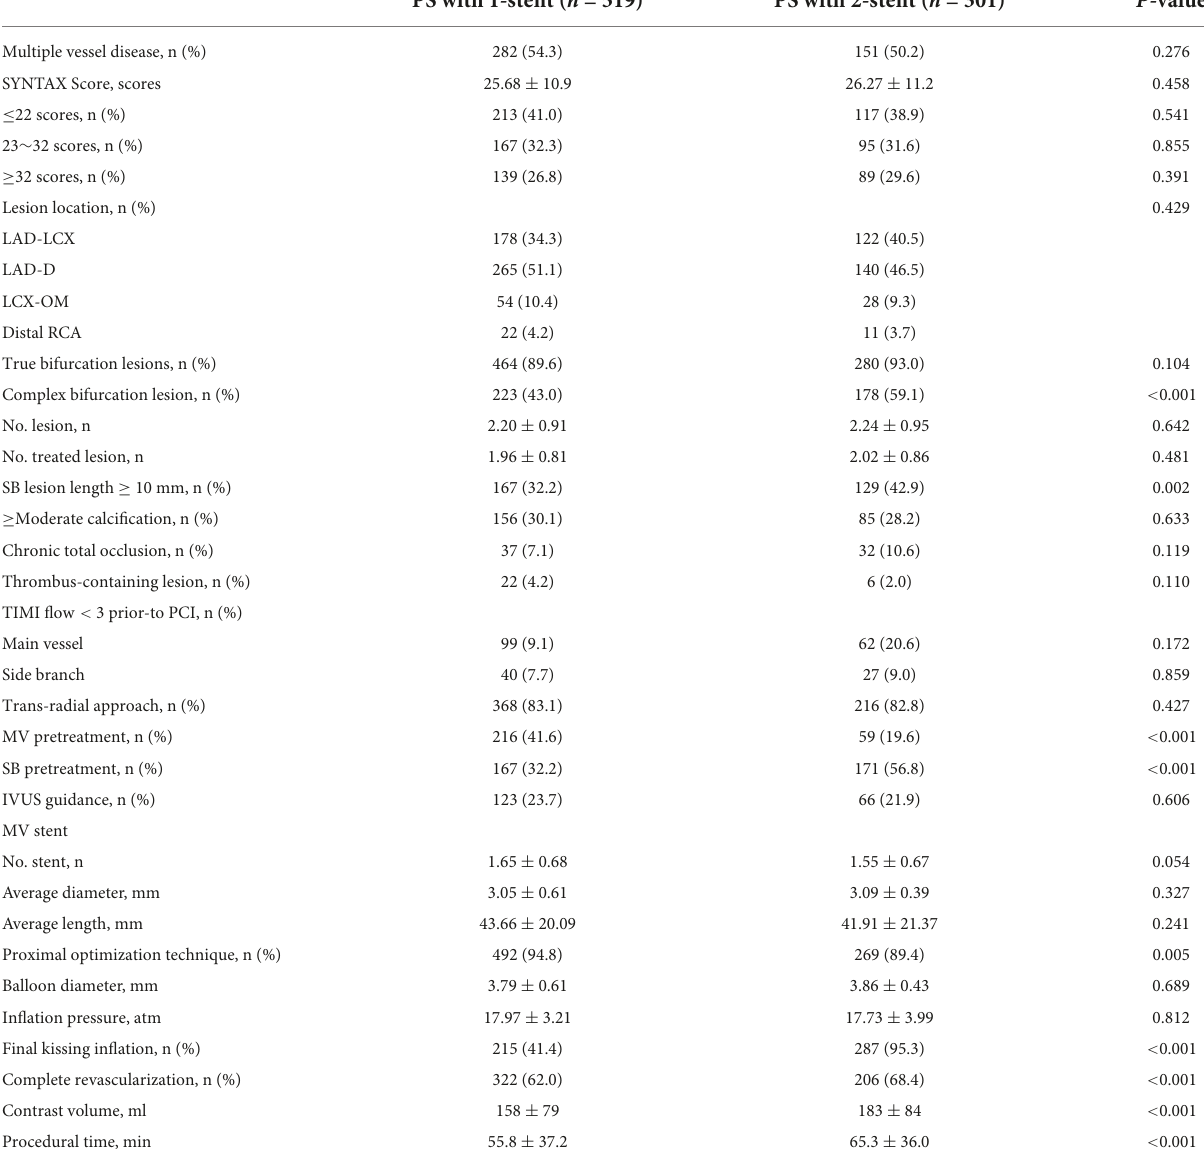
TABLE 2 Lesions and procedural